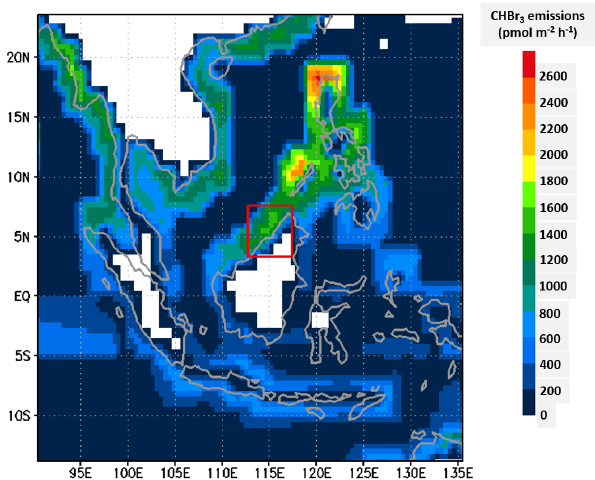
Figure 3. Map of the annual CHBr 3 emission distribution in pmolm − 2 h − 1 used in C-CATT-BRAMS in the largest model do- main (Ziska et al., 2013). The vertical axis is latitude (degrees north), and the horizontal axis is longitude (degrees east). The red rectangle corresponds to the domain of the finest-grid domain dis- played in Figs. 1 and